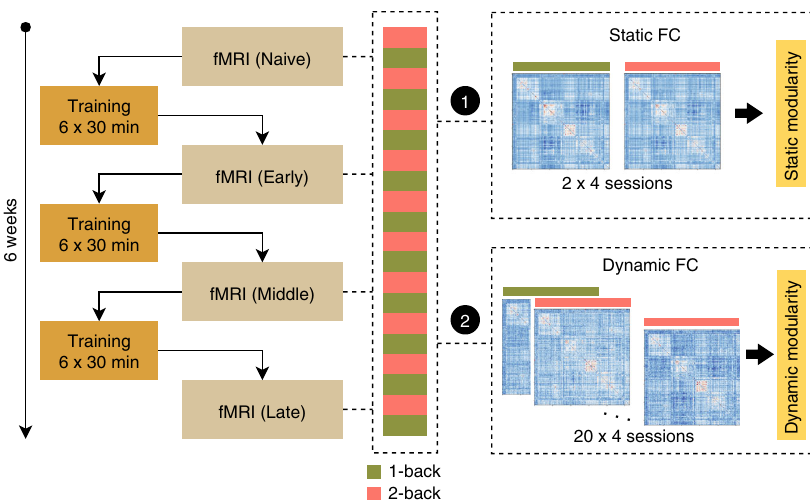
Fig. 1 Study design. (Left) The dual n-back working memory task was performed in the scanner on the fi rst day of the experiment (Naive), after 2 weeks of training (Early), after 4 weeks of training (Middle), and after 6 weeks of training (Late). (Right) We investigated (1) changes in static modularity across task conditions (1-back versus 2-back), and (2) dynamic fl uctuations in network community structure from block to